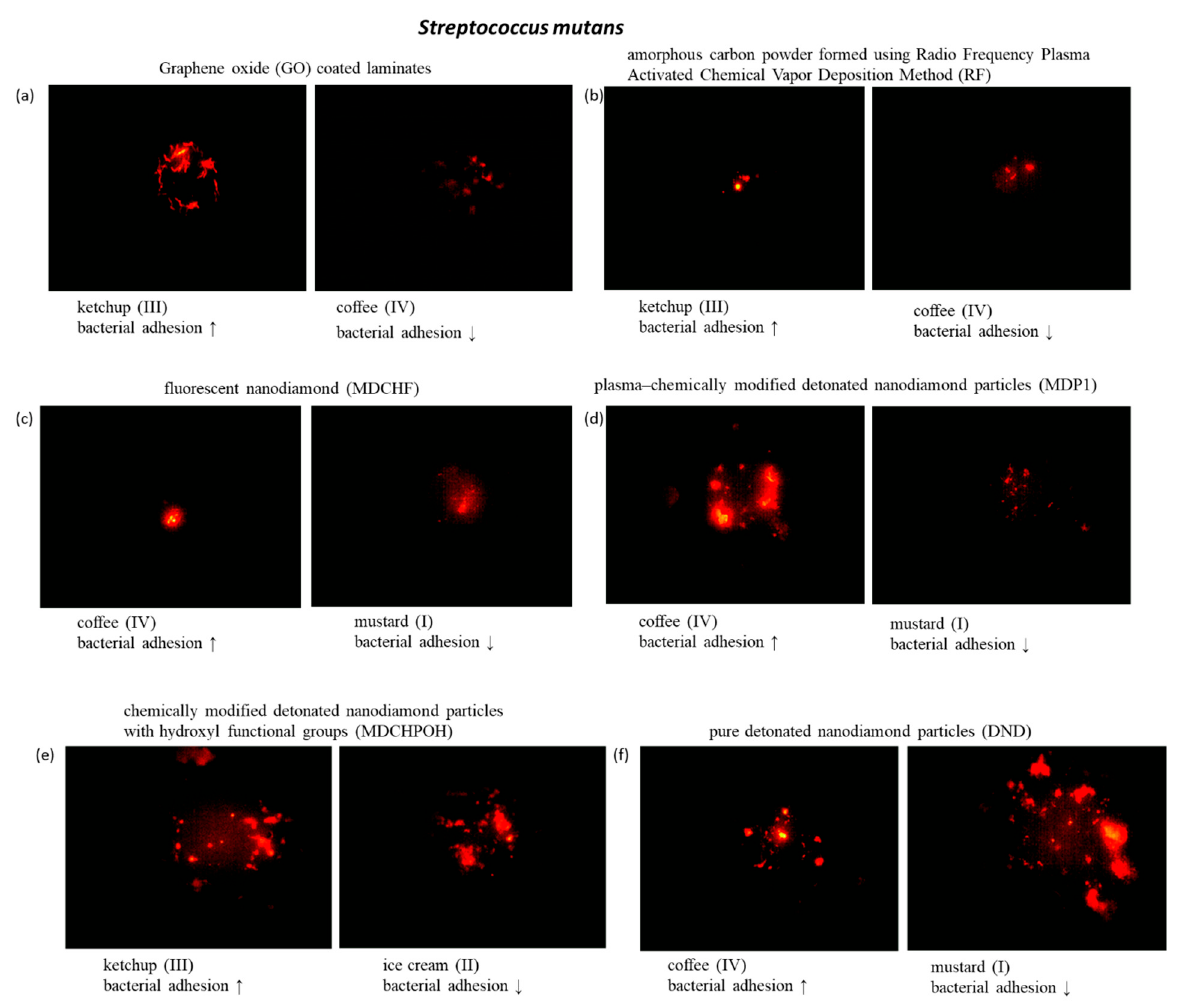
Figure 14. Images of Streptococcus mutans adhesion to laminates for food films I—mustard, II—ice cream, III—ketchup, IV—coffee, with the lowest and highest adhesion to layers formed by: ( a ) Graphene Oxide (GO) film; ( b ) amorphous carbon powder formed using Radio Frequency Plasma Activated Chemical Vapor Deposition Method (RF); ( c ) fluorescent nanodiamond (MDCHF); ( d ) plasma–chemically modified detonated nanodiamond particles (MDP1); ( e ) chemically modified detonated nanodiamond particles with hydroxyl functional groups (MDCHPOH); ( f ) pure detonated nanodiamond particles (DND).